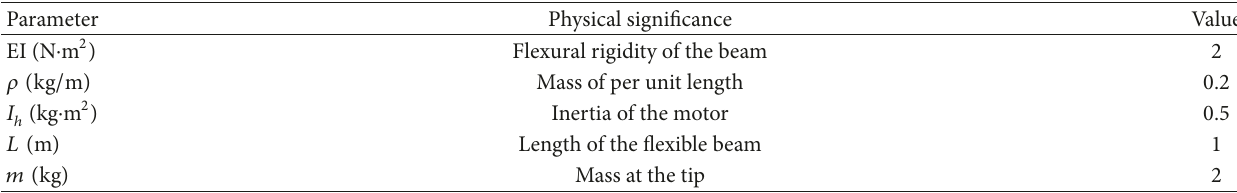
Table 1: Physical parameters of the